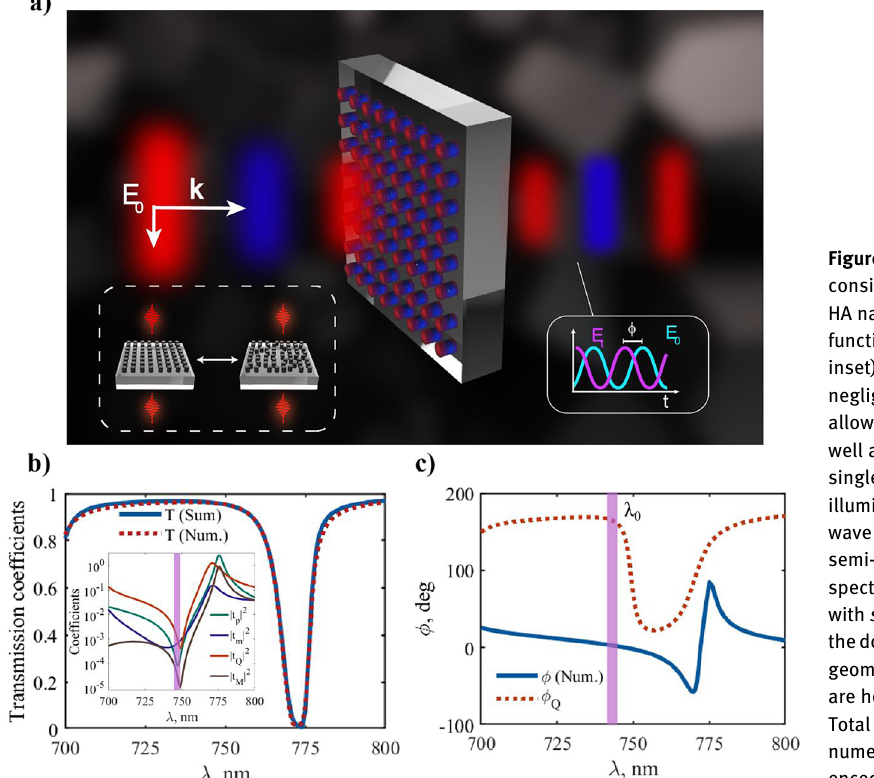
Figure 1: (a) Schematic overview of the considered Si metasurfaces composed of HA nanoparticles, illustrating its new functionalities: full transmission (left inset), phase control (right inset), and negligible electromagnetic coupling, allowing for the design of ultracompact, as well as disordered arrays retaining the single-particle response. The structure is illuminated with a normally incident plane wave with amplitude E 0 . (b) Numerical and semi-analytical [Eq. (6)] transmission spectra obtained for an HA metasurface with s = 300 nm (inset: absolute values of thedominantmultipolarcontributions).The geometrical parameters of the meta-atom are height 370 nm and radius 130 nm. (c) Total transmitted phase ϕ obtained numerically, and phase variation experi- enced by the electric quadrupole ϕ Q